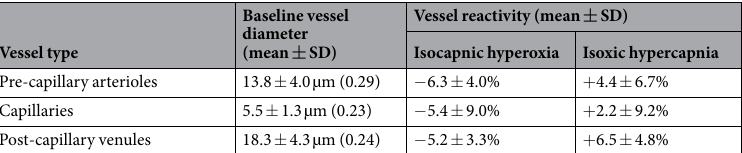
Table 2. Summary of mean ± SD (coefficient of variation) baseline vessel diameter and mean ± SD proportional changes in vessel diameter measured in all segments during systemic gas